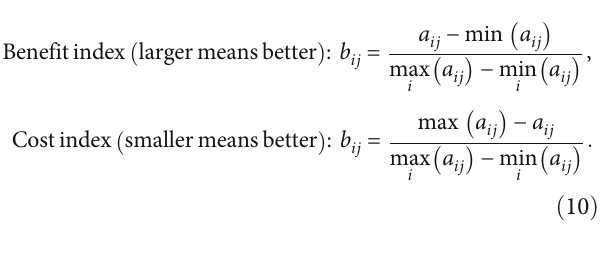
Through normalization processing of data, a normal- ized index matrix is obtained in Table 4.